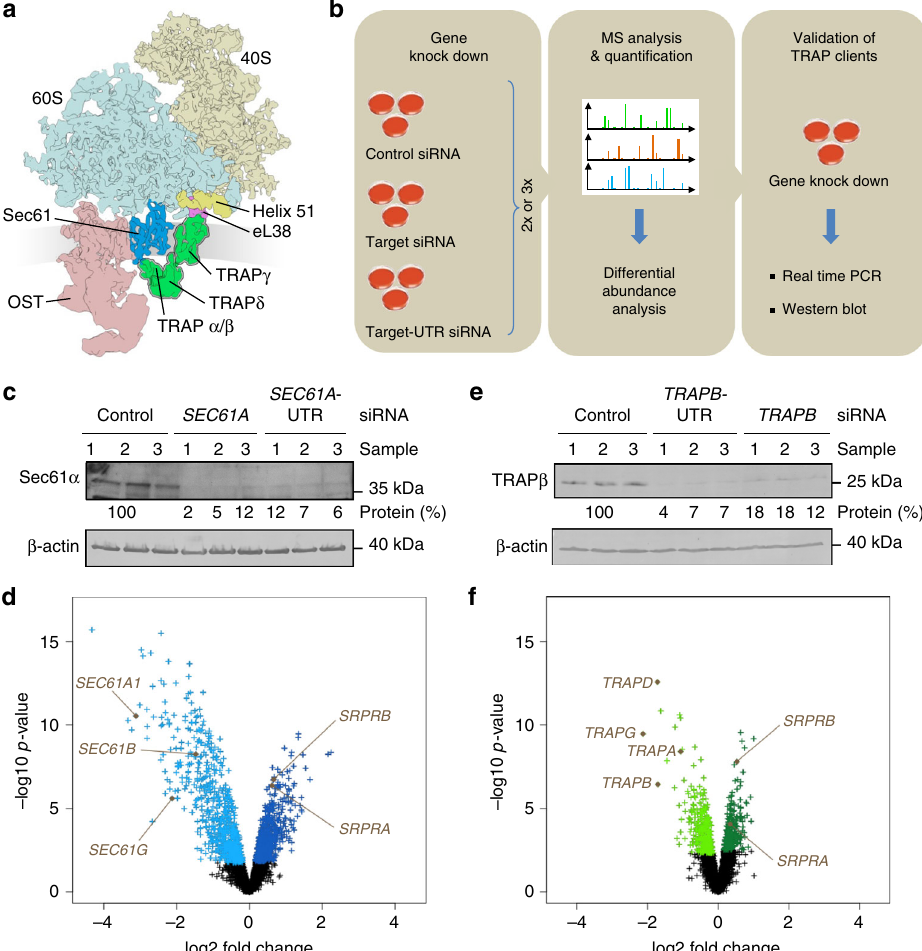
Fig. 1 Identi fi cation of TRAP clients and compensatory proteins by TRAP depletion in HeLa cells. a Cartoon of clipped 80S ribosome together with Sec61- complex (blue color code in subsequent panels and fi gures), TRAP-complex (green color code in subsequent panels and fi gures), and OST 27 . Without clipping, eL38 and helix 51 would be partially hidden. b The experimental strategy was as follows: siRNA-mediated gene silencing using two different siRNAs for each target and one non-targeting (control) siRNA, respectively with six/nine replicates for each siRNA in two/three independent experiments; label-free quantitative proteomic analysis; and differential protein abundance analysis to identify negatively affected proteins (i.e., clients) and positively affected proteins (i.e. compensatory mechanisms). c , e Knock-down ef fi ciencies in experiment 1 were evaluated by western blot. Results are presented as % of residual protein levels (normalized to ß-actin) relative to control, which was set to 100%. Blot results for other experiments are shown in Supplementary Fig. 1a, d. d , f Differentially affected proteins were characterized by the mean difference of their intensities plotted against the respective permutation false discovery rate-adjusted p -values in volcano plots ( n = 2 in the case of Sec61 depletion, n = 3 in the case of TRAP depletion). The results for a single siRNA are shown in each case ( SEC61A1- UTR siRNA, TRAPB siRNA). Additional plots are shown in Supplementary Fig. 1c, f. Subunits of the Sec61- and TRAP-complexes and of the SRP receptor are